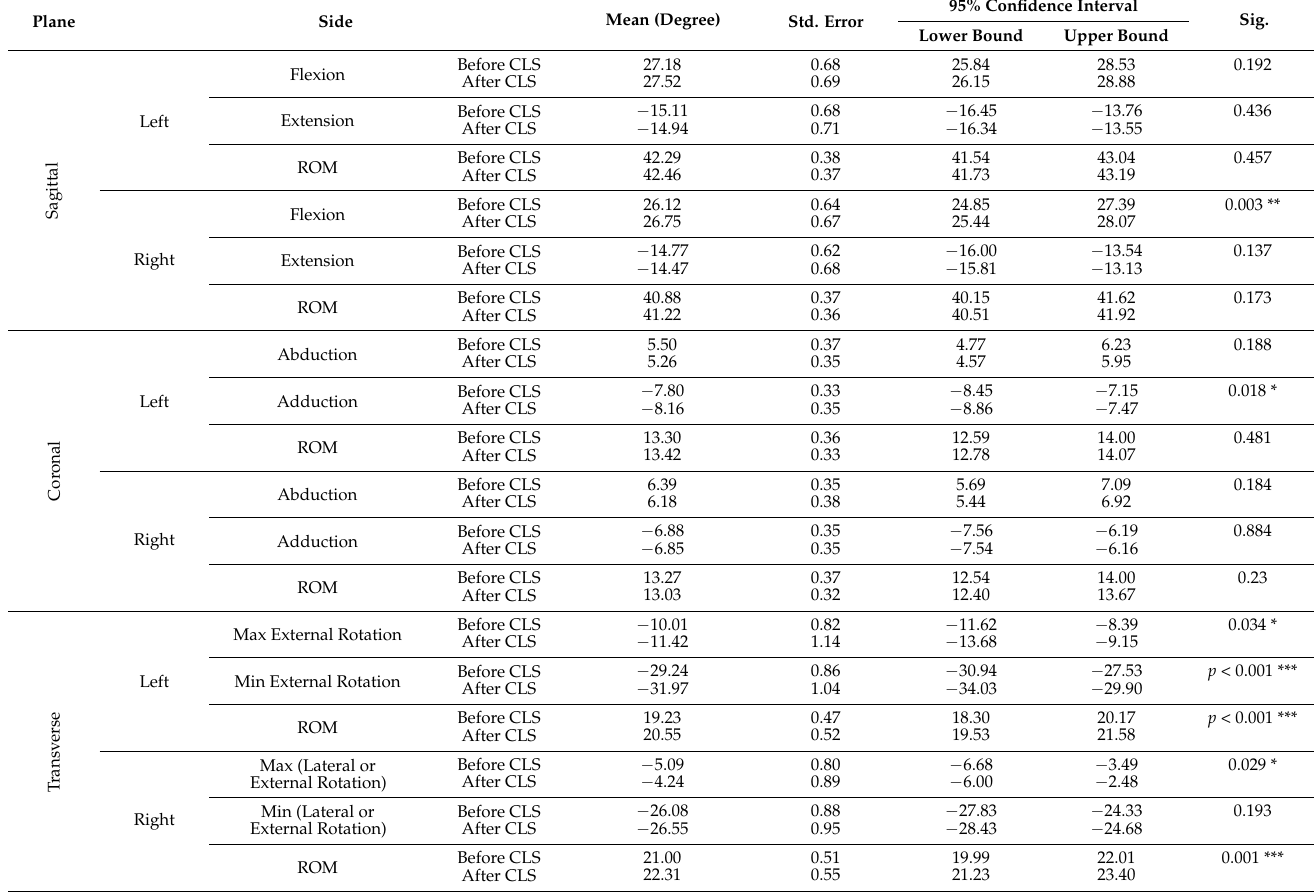
Table 3. Hip Joint Angle in sagittal, coronal, and transverse